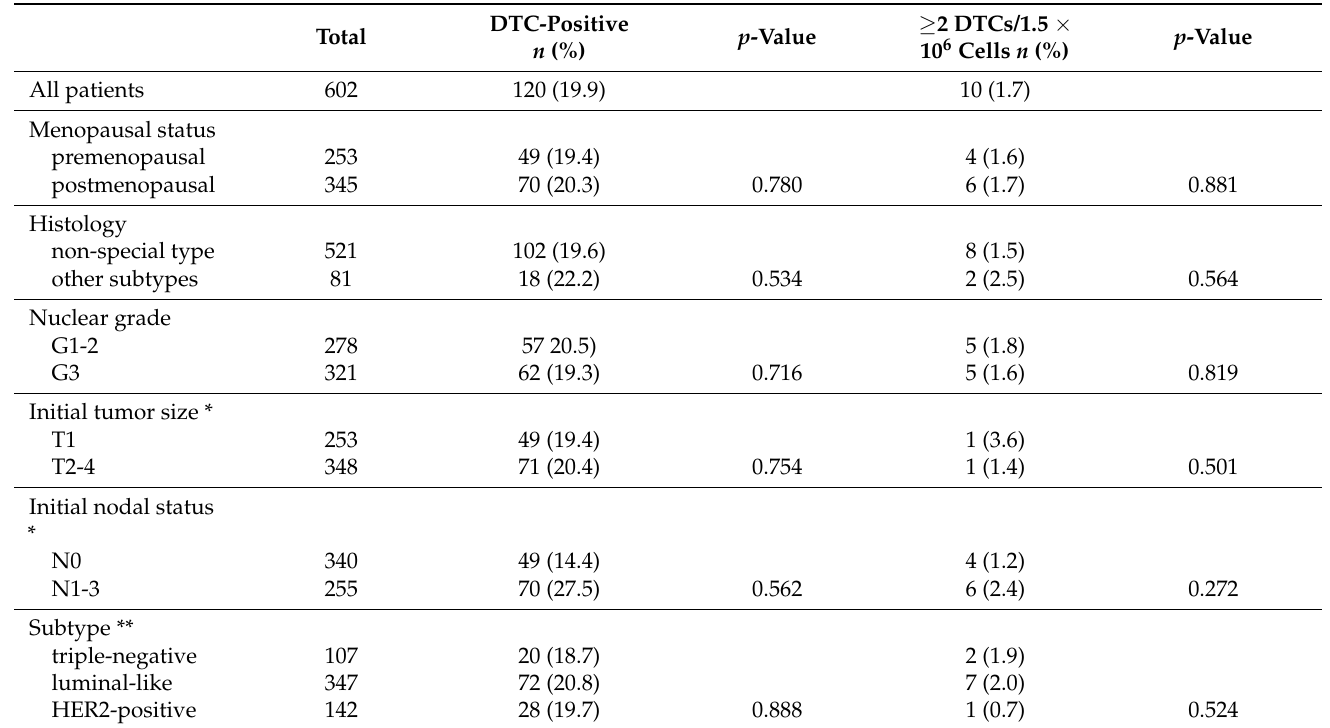
Table A1. Patient characteristics according to the detection of disseminated tumor cells in patients who received adjuvant